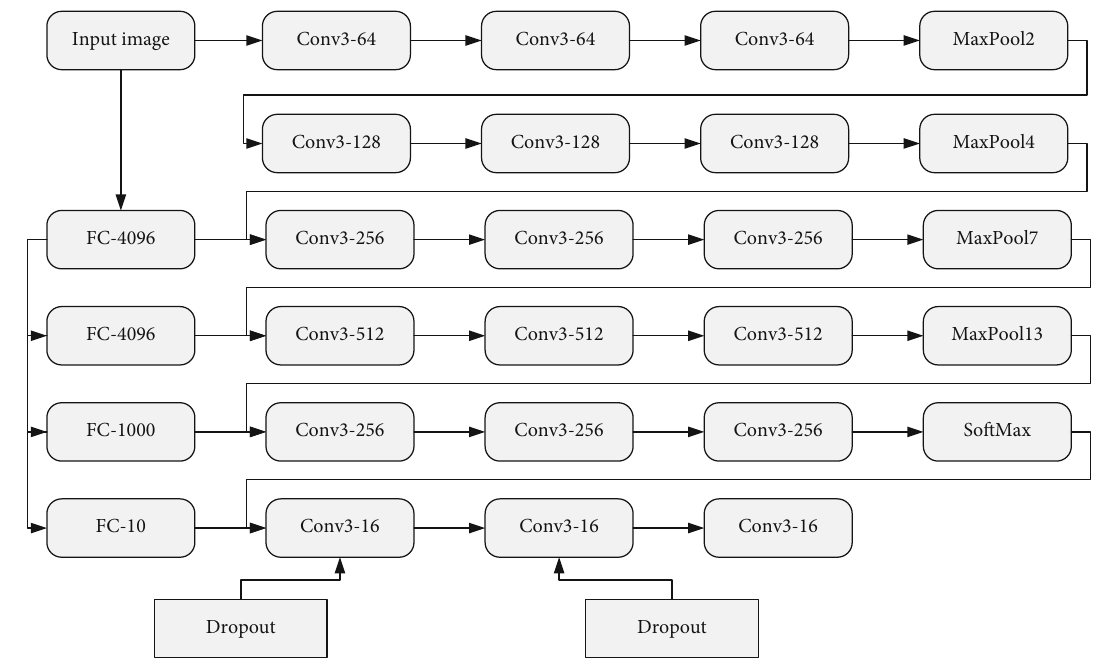
Figure 2: Network framework